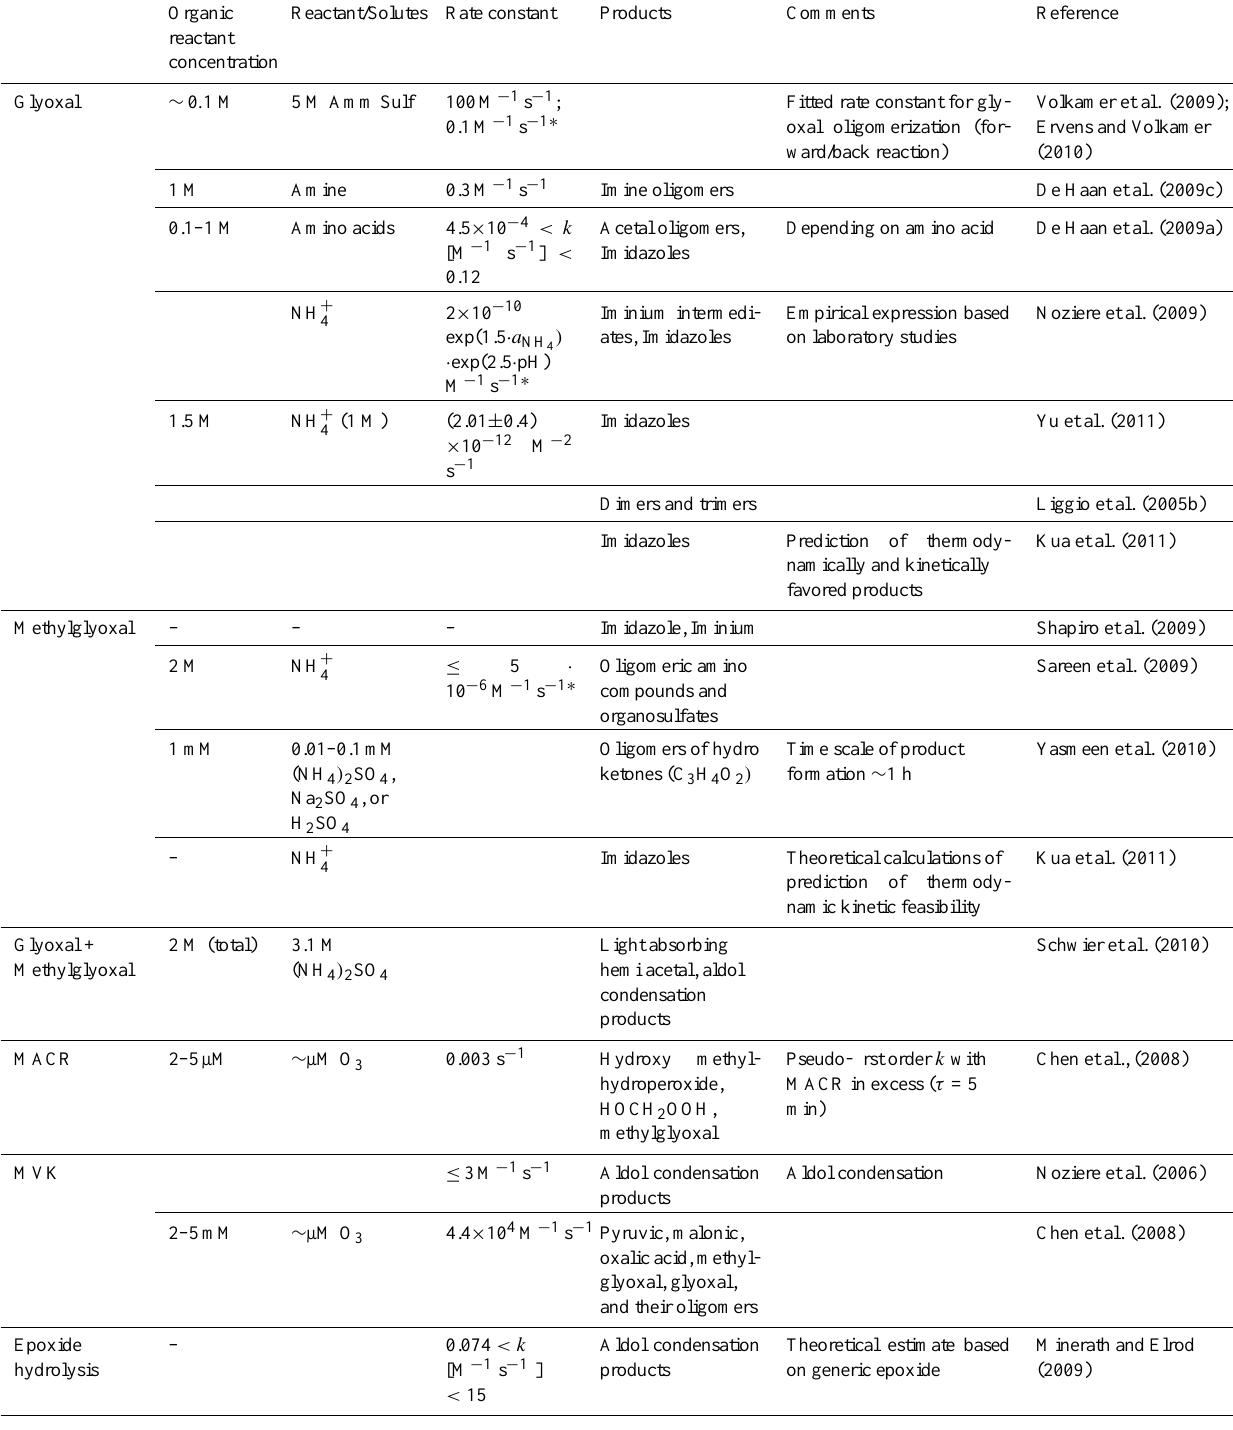
Table 2. Summary of experimental conditions, kinetic data and products from dark (non-photochemical) reactions in laboratory experiments leading to